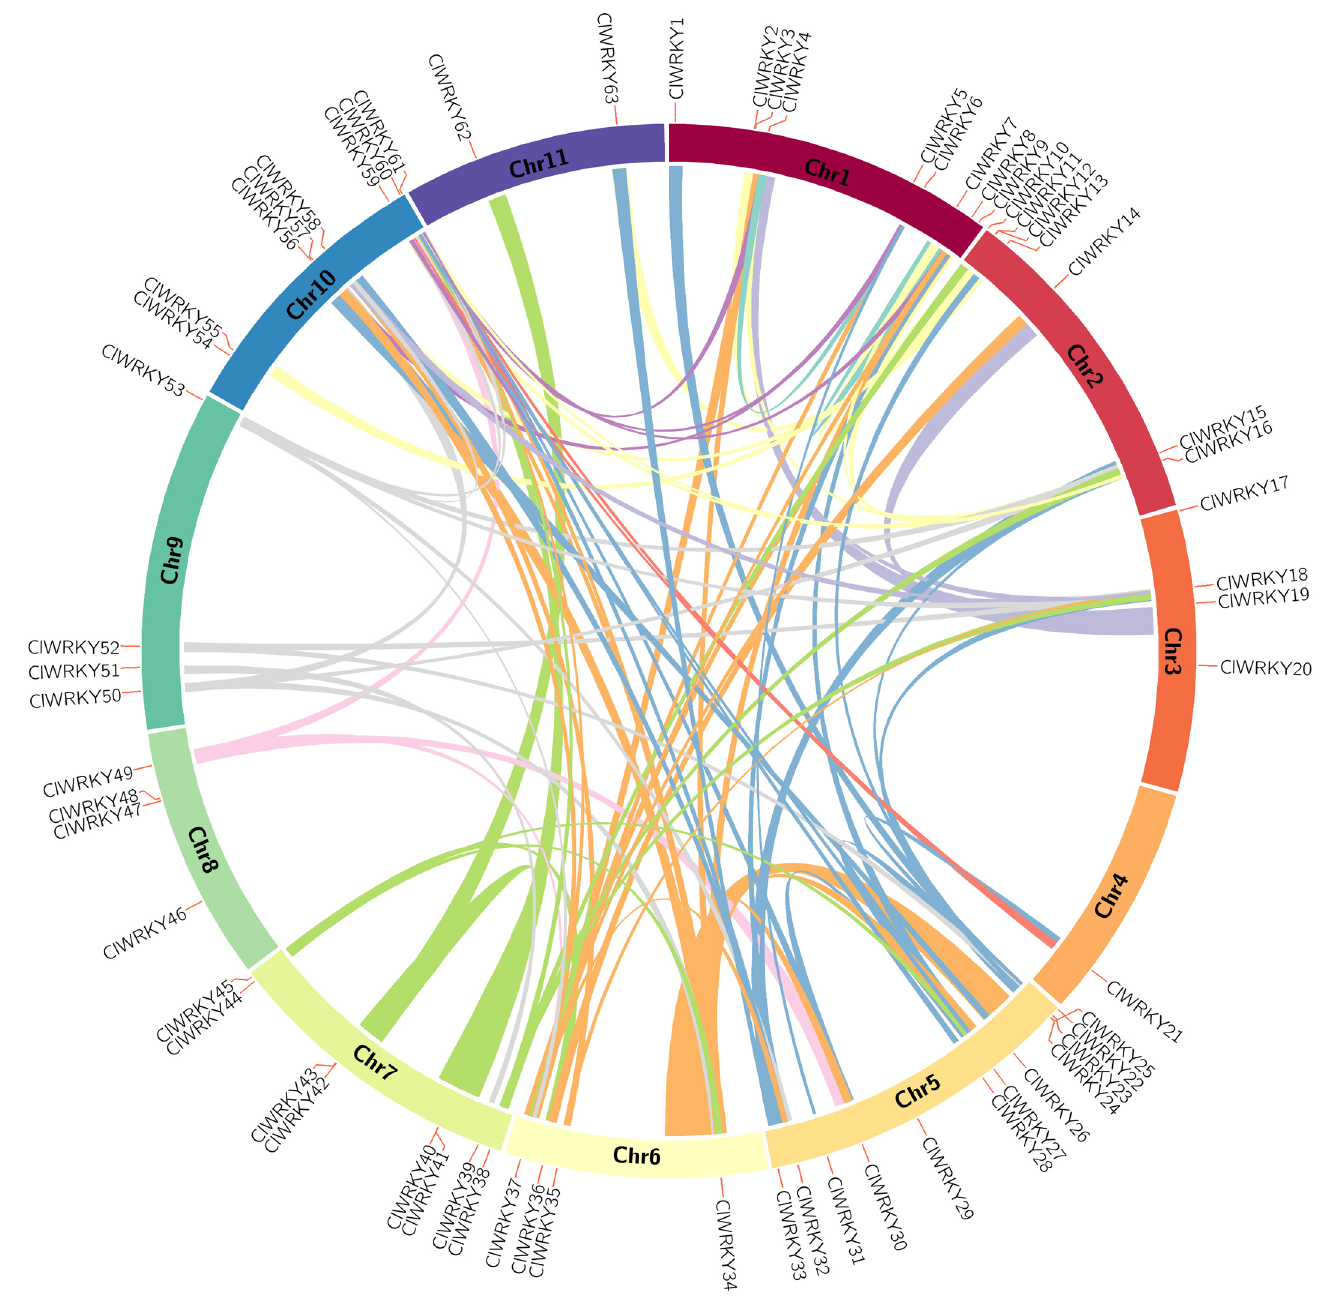
Fig 5. Synteny analysis of watermelon WRKY genes. Chromosomes 1–11 were shown with different colors and in a circular form. Colored curves indicated the details of syntenic regions in watermelon genome.